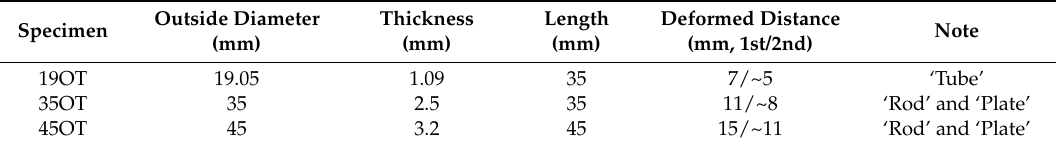
Table 3. Dimensions of ovalized tube (OT)